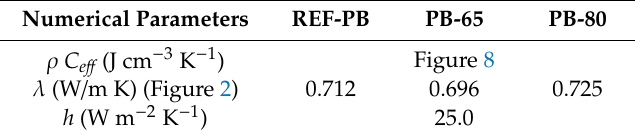
Table 4. Overview of the numerical parameters assumed for the PB